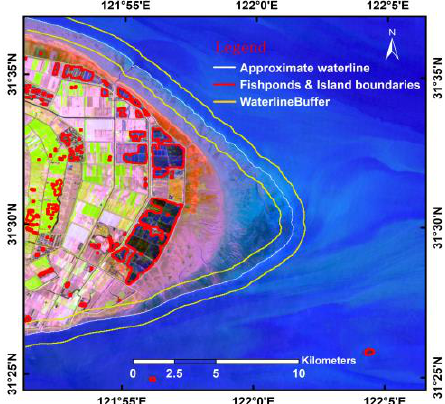
Figure 2. On the remote sensing image of 20 April 2007, the spatial relationship of the low-spatial resolution